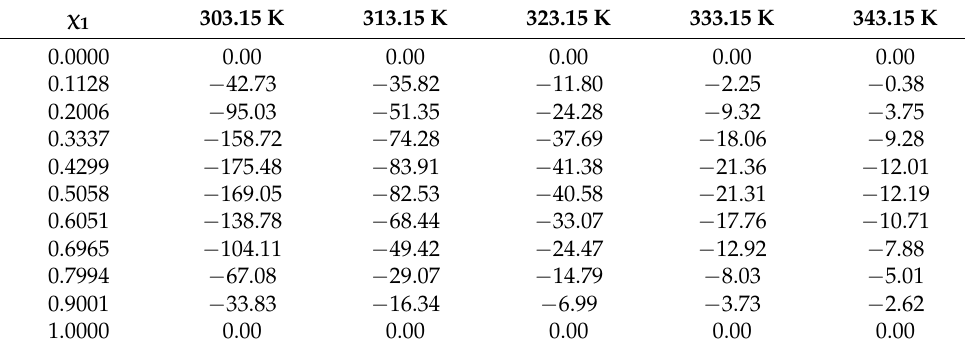
Table 4. Viscosity deviations of ([EMIM] [TFA] + TEA) (mPa · s) a